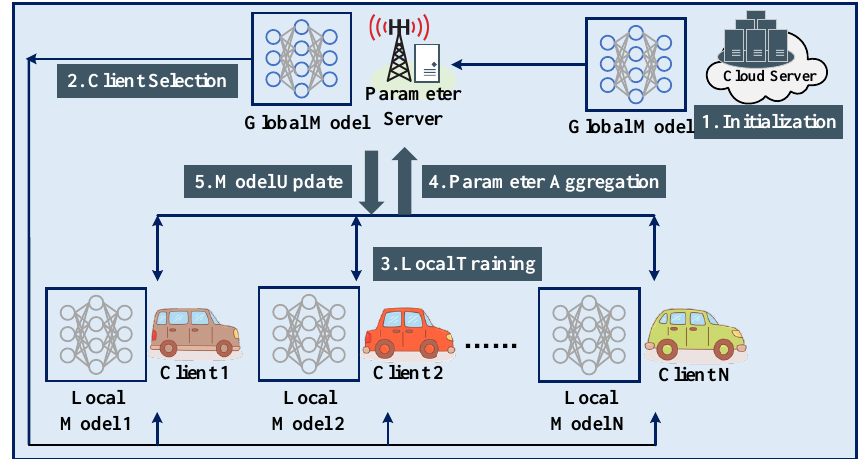
Figure 3. Diagram of federated AI model training with client selection in